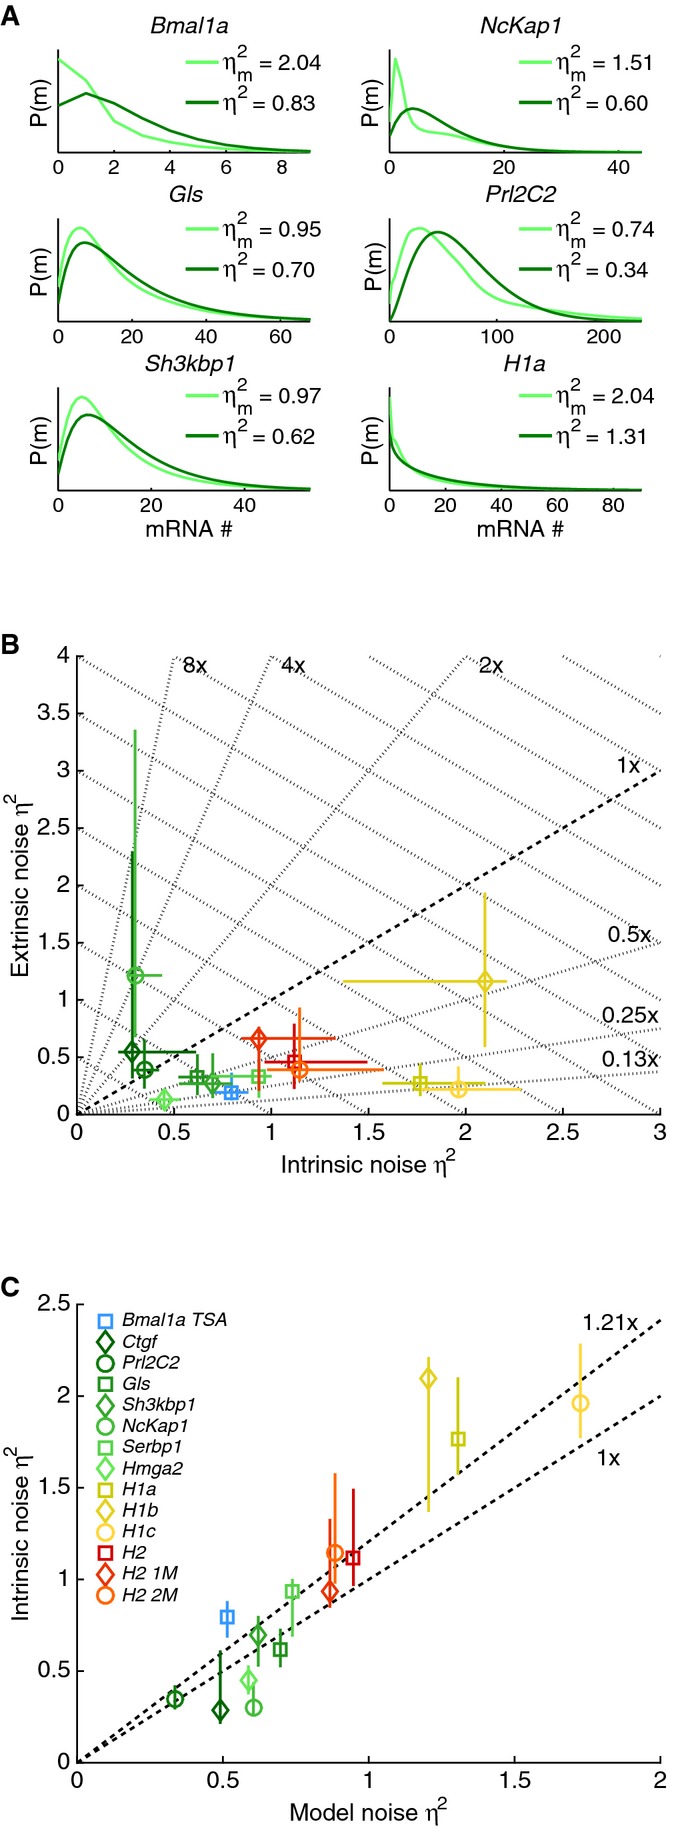
Separating intrinsic and extrinsic noise
mRNA distribution (Gibbs, light green) and steady-state distribution of the optimal promoter cycle (dark green). Differences, also reflected in the noise values, originate from extrinsic variability.

Separation of the total noise in intrinsic and extrinsic components. For the majority of clones, intrinsic noise dominates.

The modeled noise corresponds to 83% of the estimated intrinsic noise on average.
Data information: In (B, C), the error bars stand for the 5th and 95th percentiles of the estimate (parametric bootstrap).